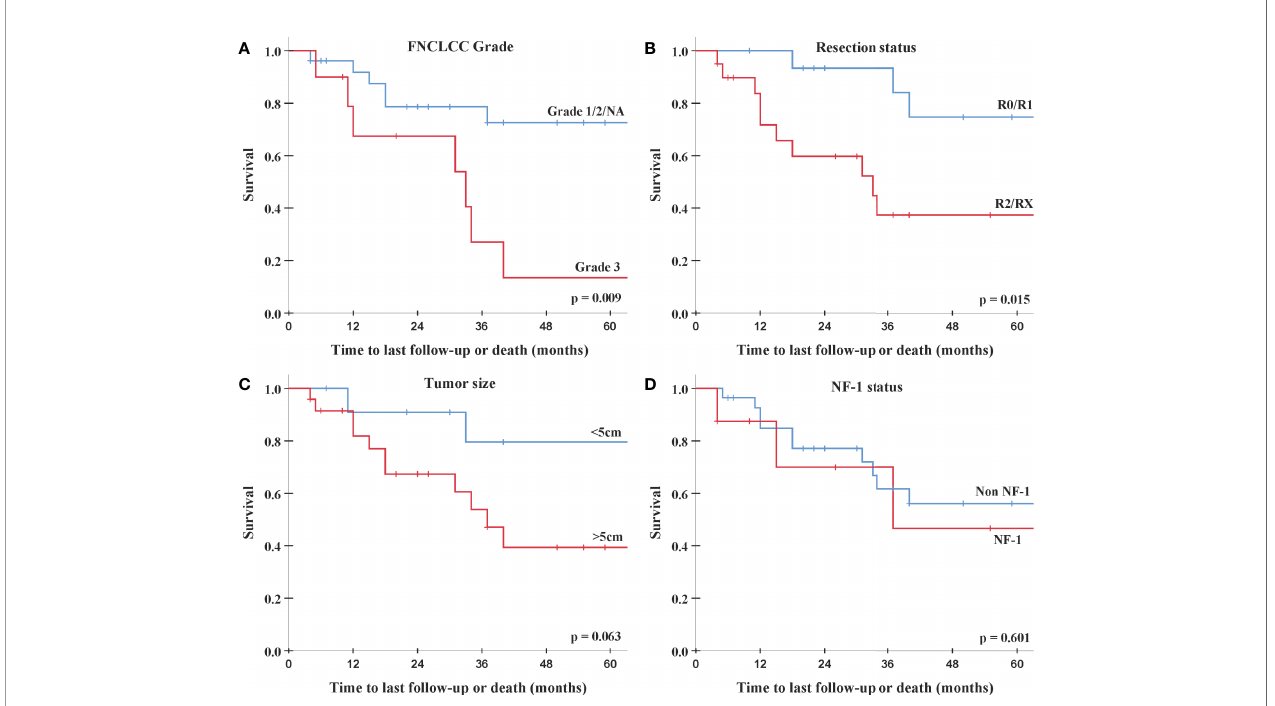
TABLE 4 | Summary of late toxicities according to CTCAE v4.1 in alphabetical order. Toxicity Grade 1